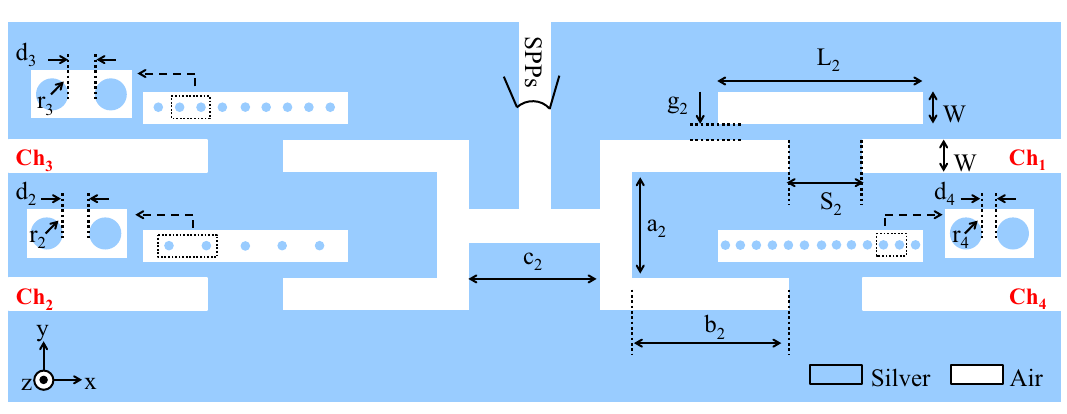
Figure 9. Schematic of the proposed four-channel DEMUX.